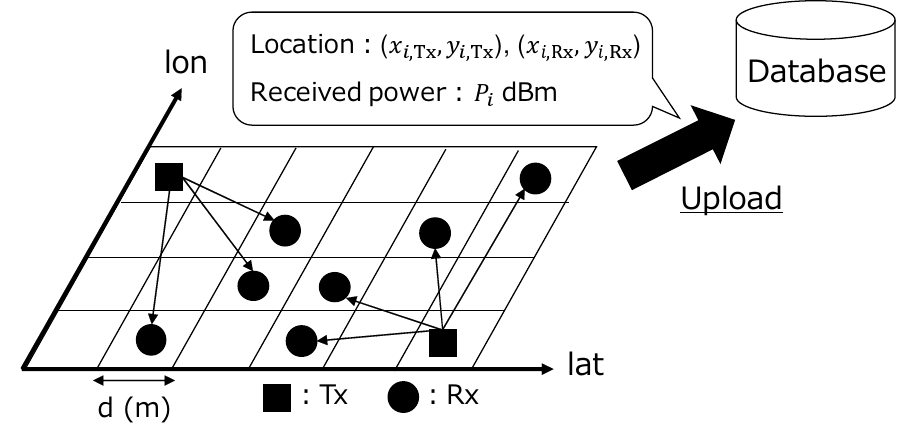
Figure 2. Data collection for database construction.